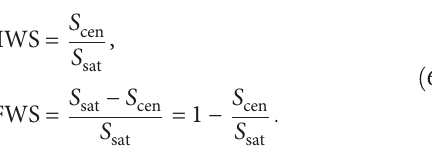
and φ values of the six cores after di ff erent cycle time and cycle e r